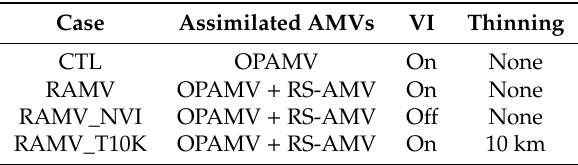
Table 1. Outline of control and sensitivity experiments.